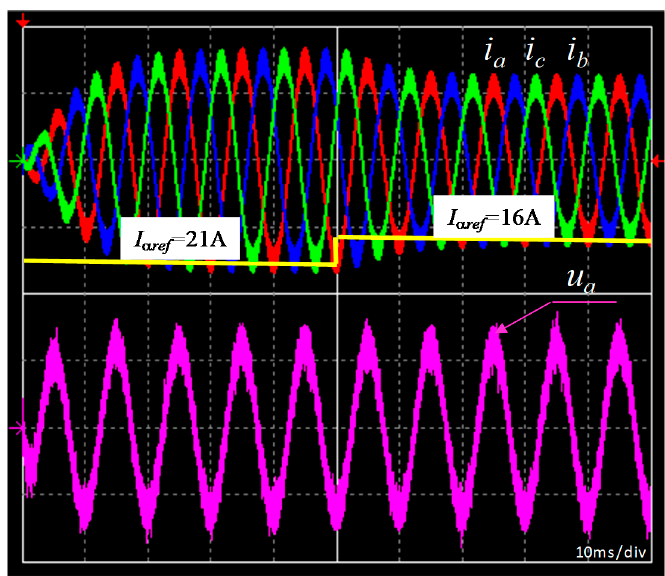
Figure 7. Grid currents i a , i b , i c in A and grid voltage u a in V for proposed P+R controller during startup process and active current change I α ref in A, measured for reactive current I β ref = 0.